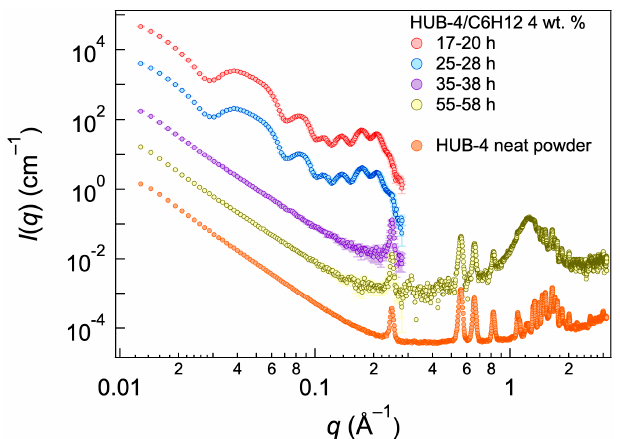
Figure 2. Small-angle X-ray scattering (SAXS) intensities of a HUB-4/C 6 H 12 gel ( c = 4 wt.%) at different times, and intensities of neat HUB-4. Between 38 and 55 h, the intensities are the same as the curve for the 35 − 38 h interval. For clarity, each curve is shifted from the previous one by a factor of 10.